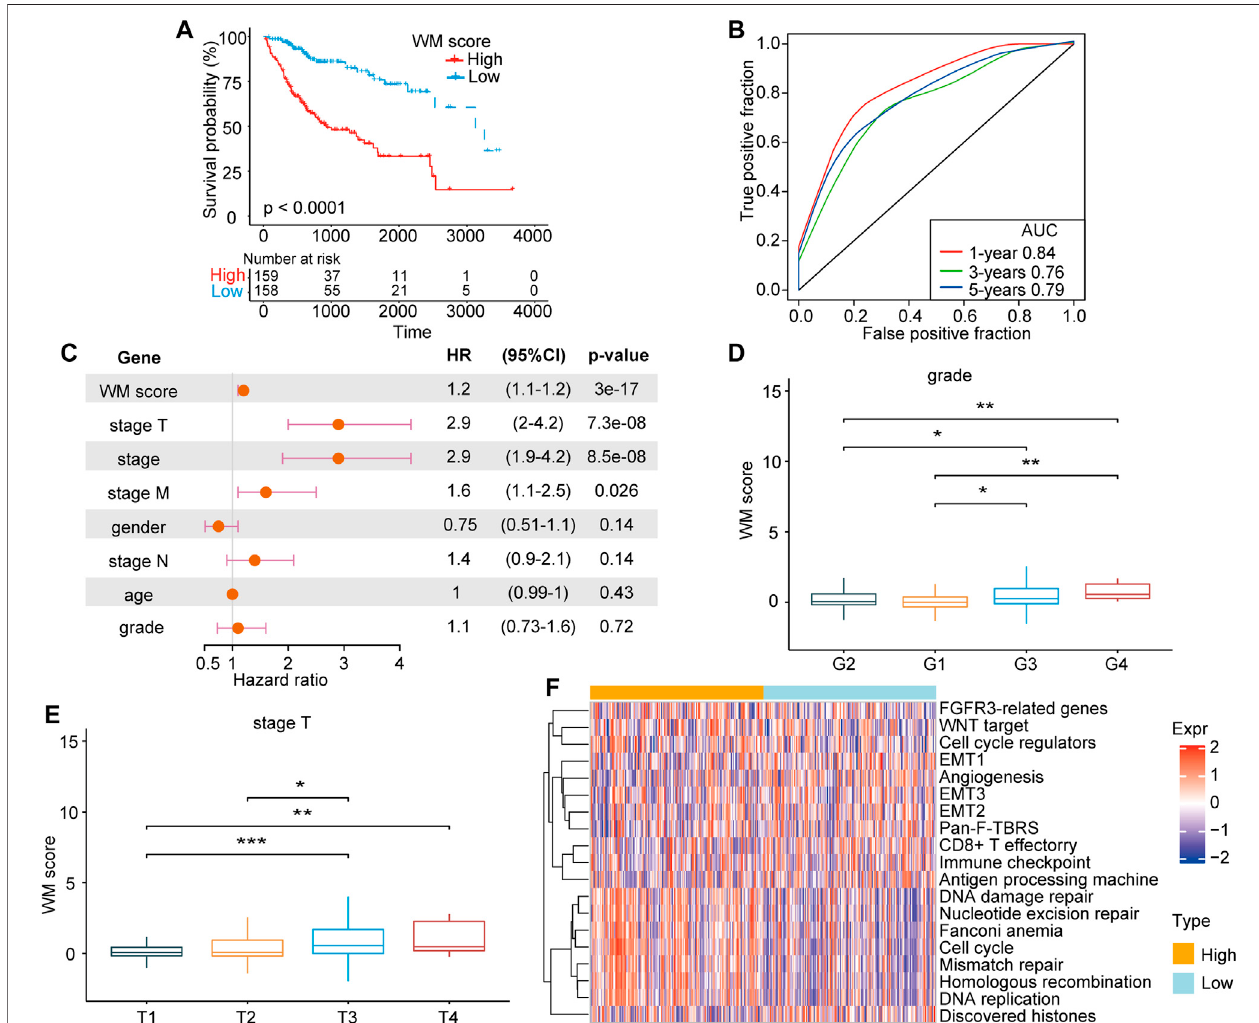
FIGURE 5 | The clinical characteristics and prognosis of HCC correlated with the WM-Score model. (A) . Kaplan-Meier overall survival for HCC patients in the high andlowWM-Scoregroups. (B) .ThepredictiveaccuracyoftheWM-ScoremodelintheTCGA-LIHCcohort(AUC:0.84,076,and0.79,correspondingto365,1,095,and 1825 days OS,respectively). (C) .Multivariate coxregressionanalysisoffactors, whichincluded WM-Score, stage-T, stage, stage-M, gender,stage-N, patientage,and grade in the TCGA-LIHC cohorts. (E) . WM-Score differences among grade and stage-T of HCC in TCGA-LIHC. (F) . Heatmap showing the GSVA score of EMT signaling pathways between different WM-Score groups in